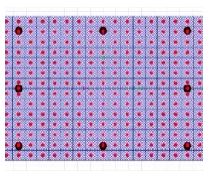
Figure 9. Fibre model of a column cross section.